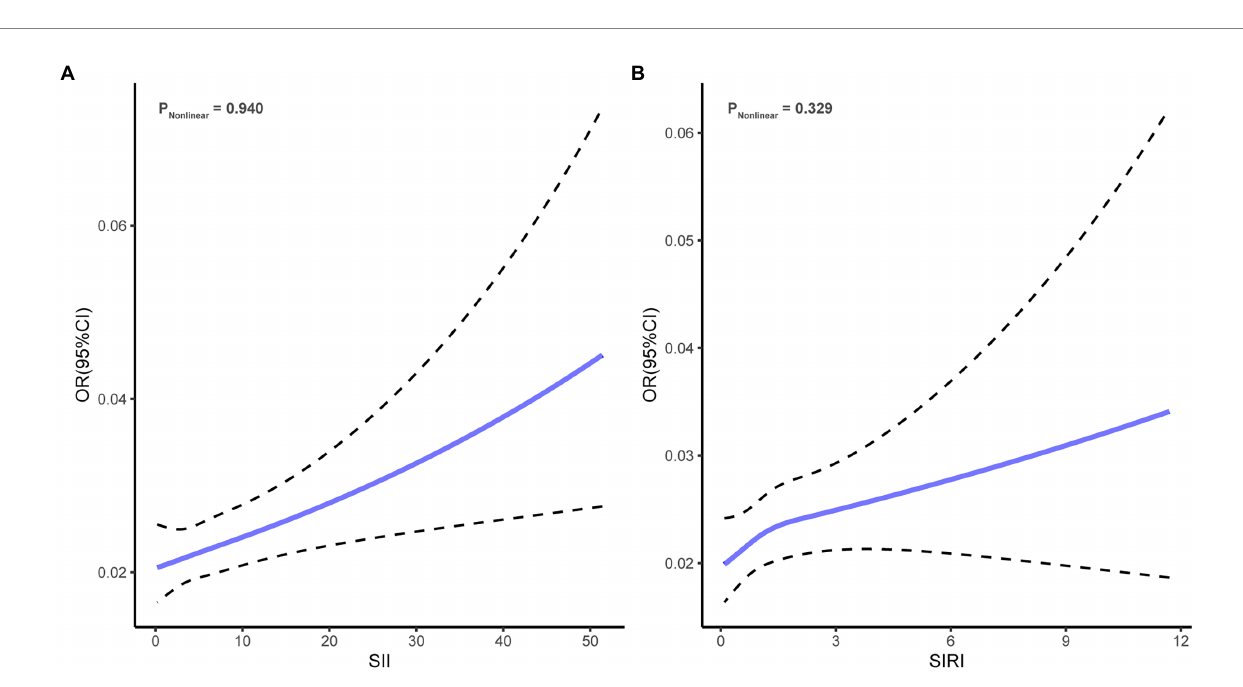
FIGURE 3 Restricted cubic spline regression curves. (A) Association of SII with depression risk. (B) Association of SIRI with depression risk. SII, systemic inflammatory index; SIRI, systemic inflammation response